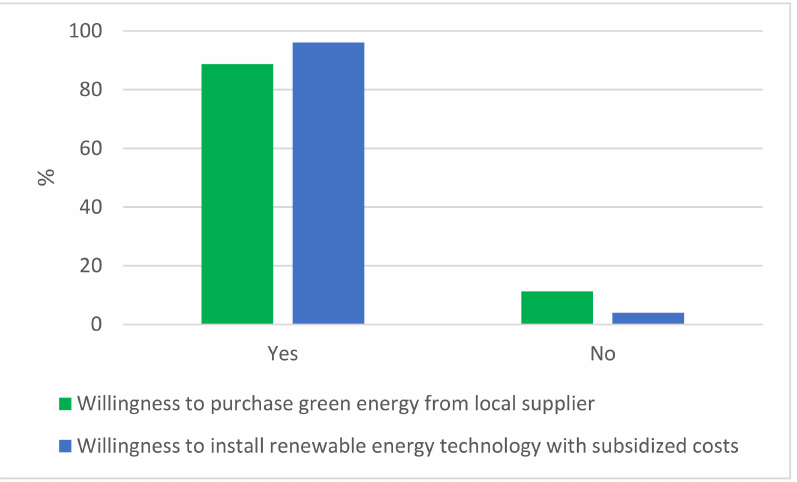
Figure 5. Willingness to purchase green energy or install renewable energy technology. Source: Authors’